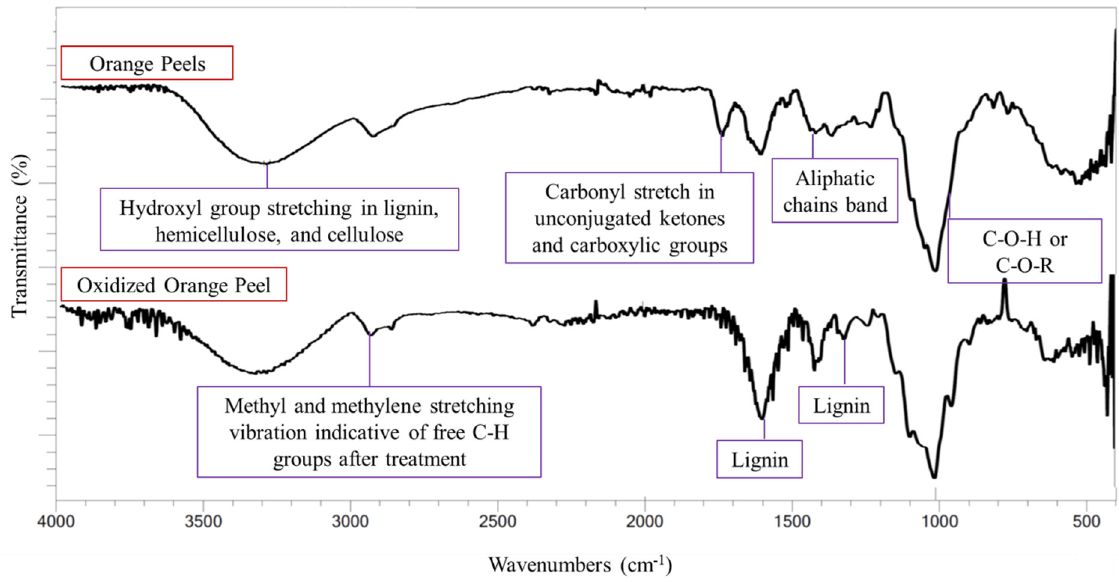
Figure 3. FTIR spectra of orange peels and oxidized orange peels.